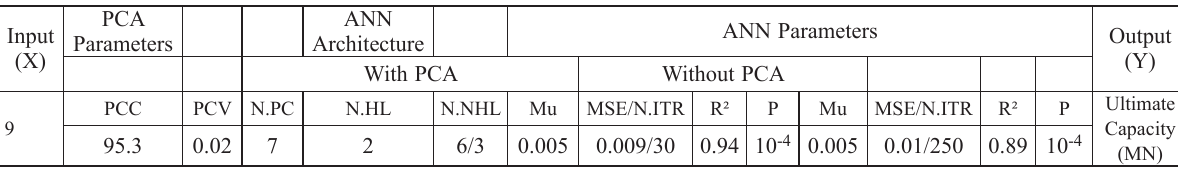
Table 5. Architecture and parameters of the developed model PCA Input Parameters (X)